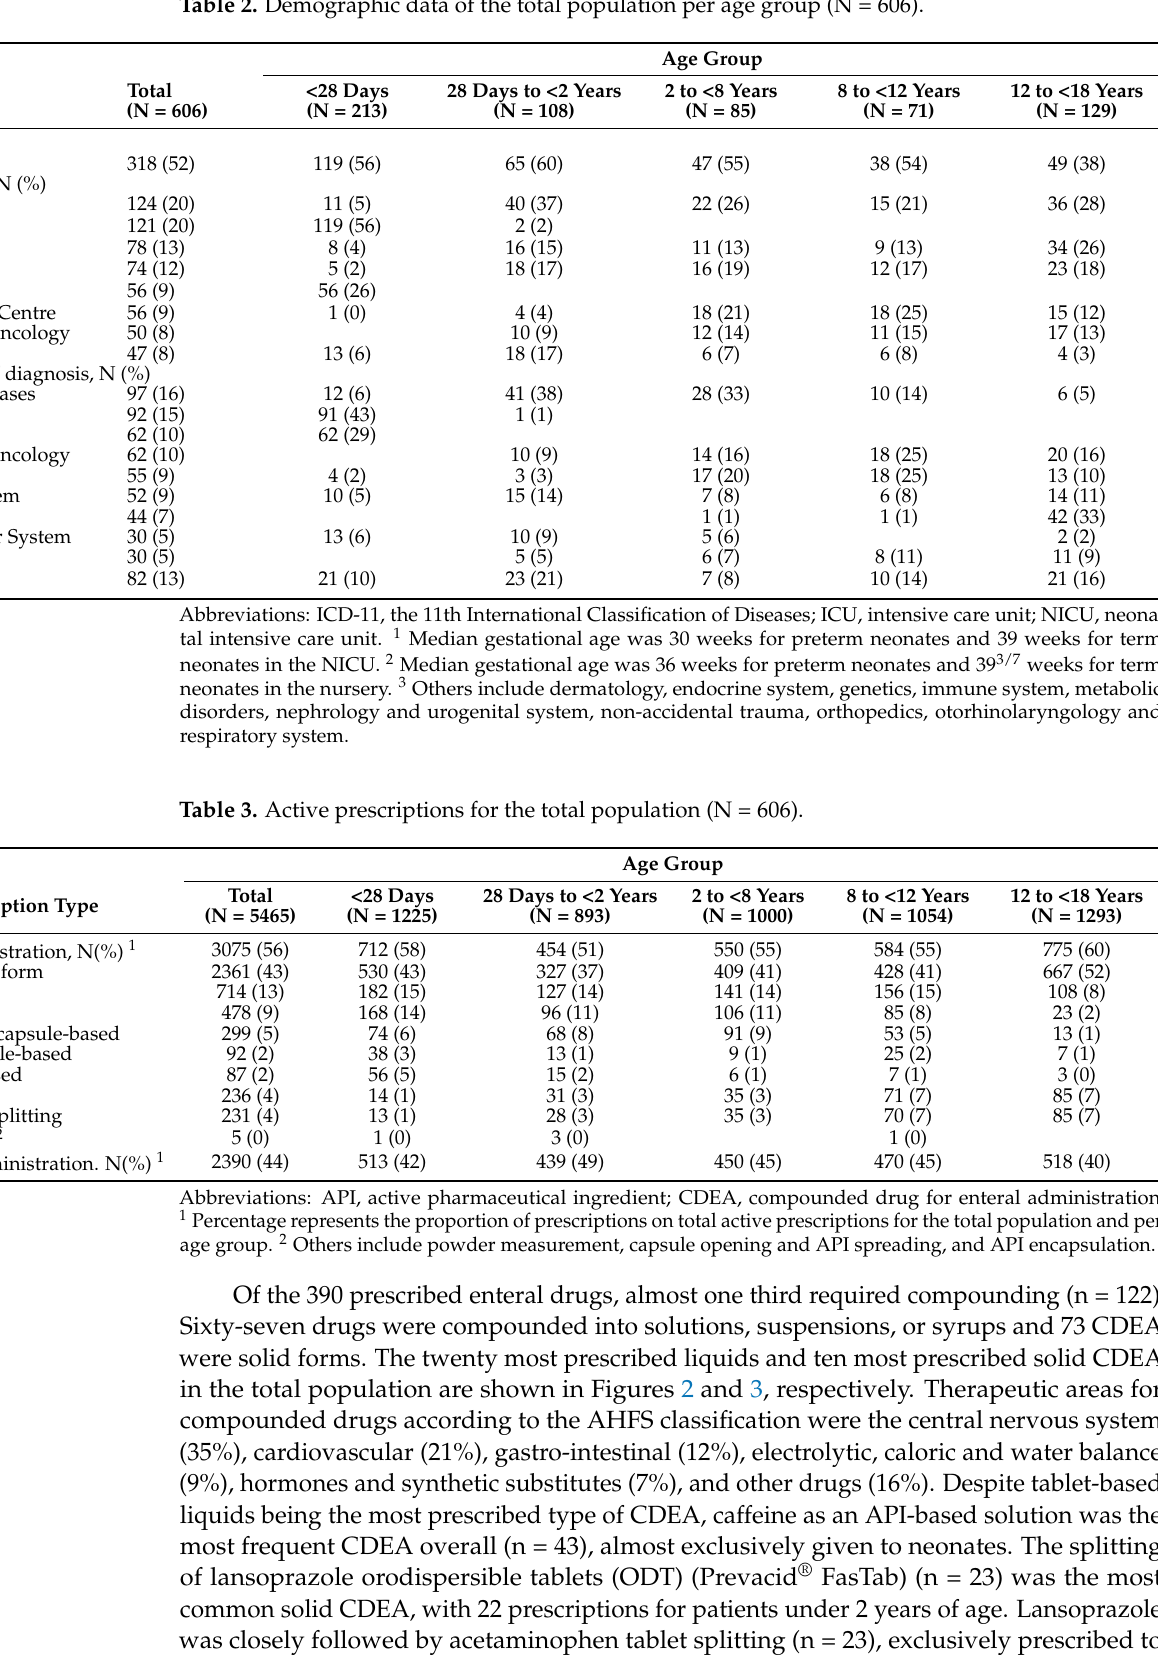
Table 2. Demographic data of the total population per age group (N = 606).